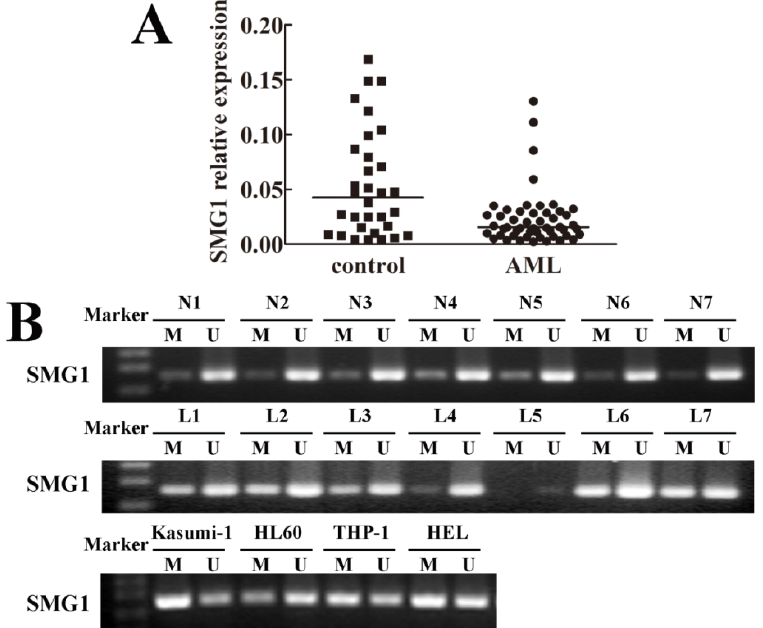
Figure 1. Epigenetic silencing of SMG1 in acute myeloid leukemia (AML) patient samples and cell lines. ( A ) Down-regulation of SMG1 confirmed by quantitative RT-PCR ( p < 0.05); ( B ) Representative Methylation-Specific Polymerase Chain Reaction (MSP) results of the SMG1 methylation status in normal controls, AML samples and AML cell lines, respectively. SMG1 was unmethylated in normal controls, but frequently hypermethylated in AML samples and cell lines. M, methylated product; U, unmethylated product; N, normal control; L, acute myeloid